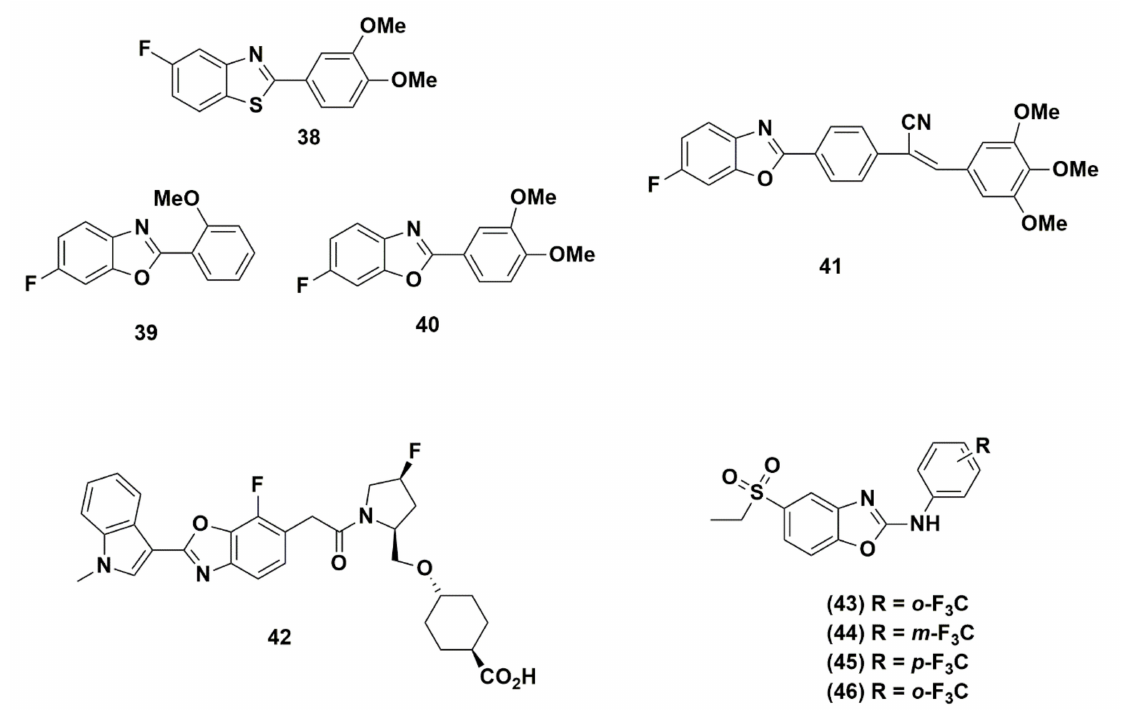
Figure 9. Benzoxazole derivatives incorporating